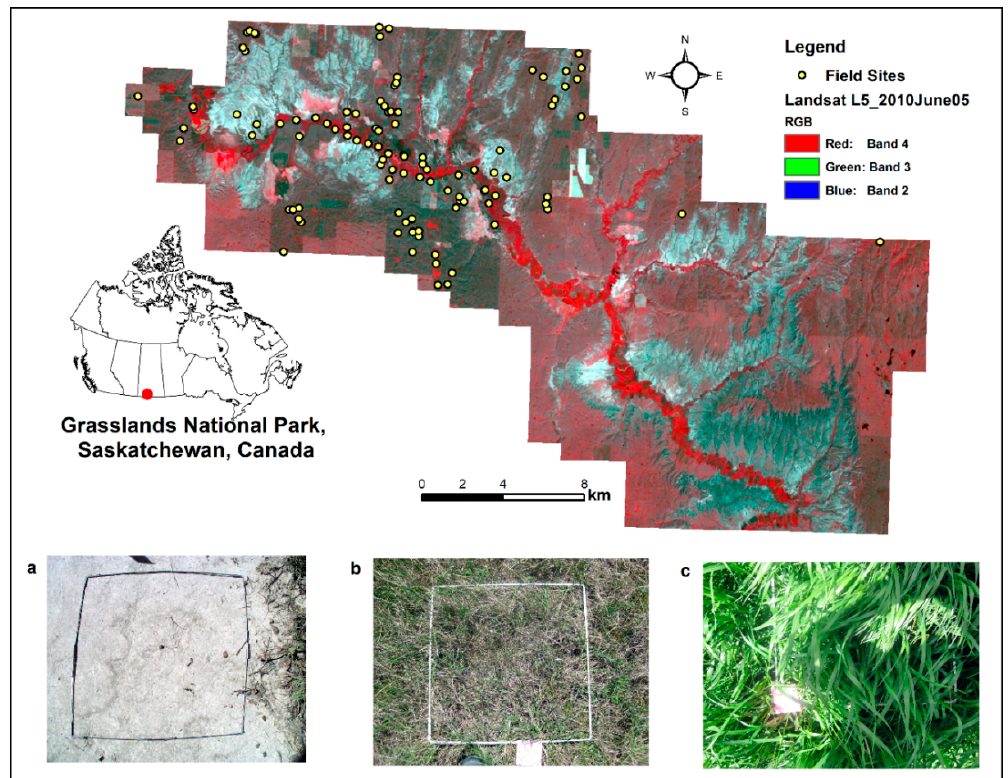
Figure 2. Study area is located in the West Block of the Grasslands National Park, Saskatchewan, Canada. ( a – c ) are photos were taken from badlands, upland grassland, and riparian grassland areas, respectively.